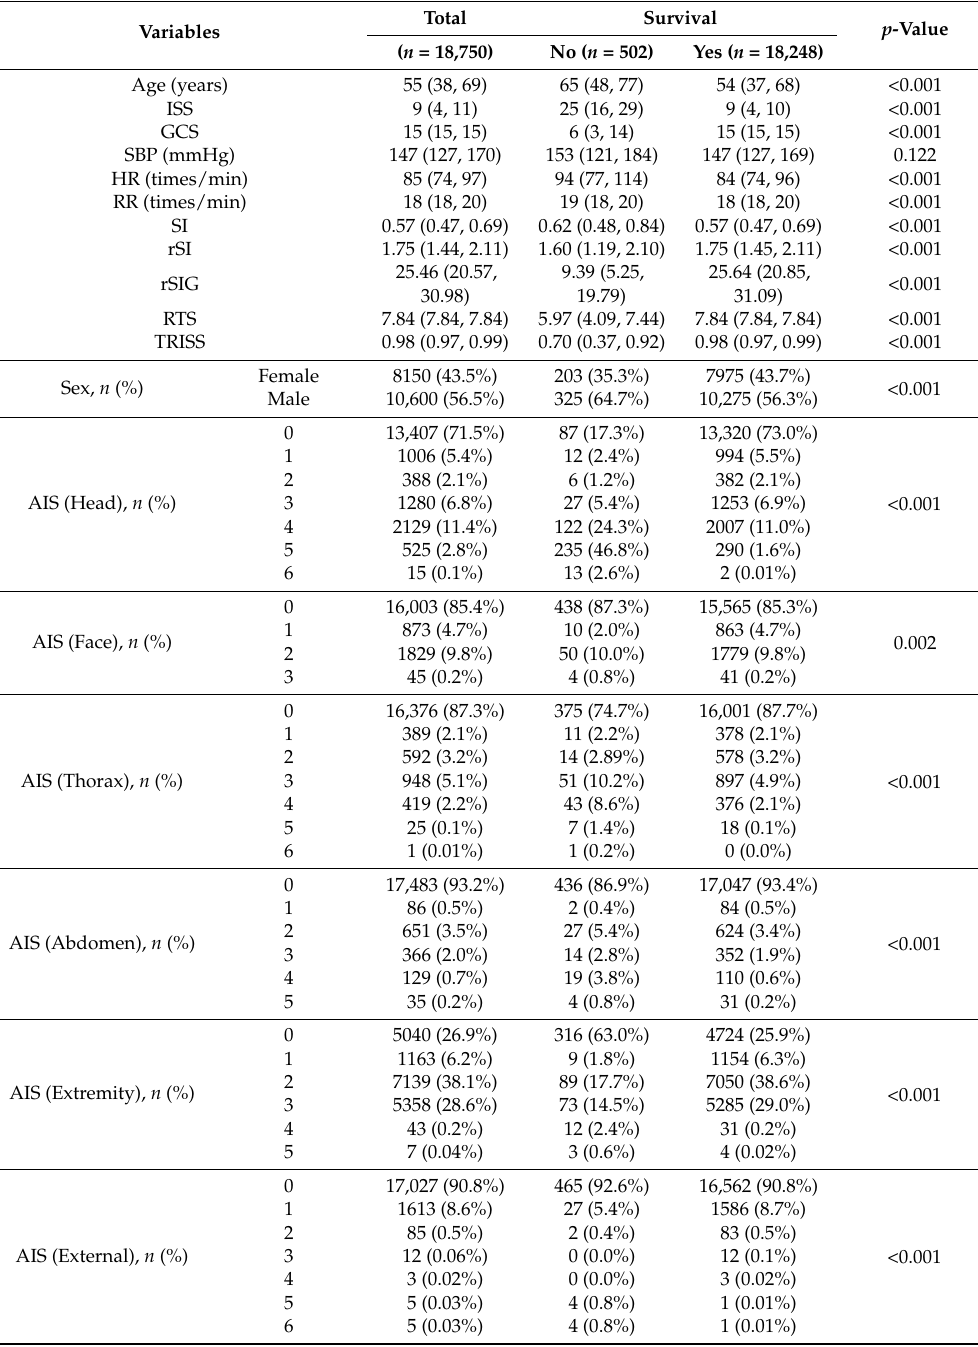
Table 1. Characteristic variables of patients with all types of